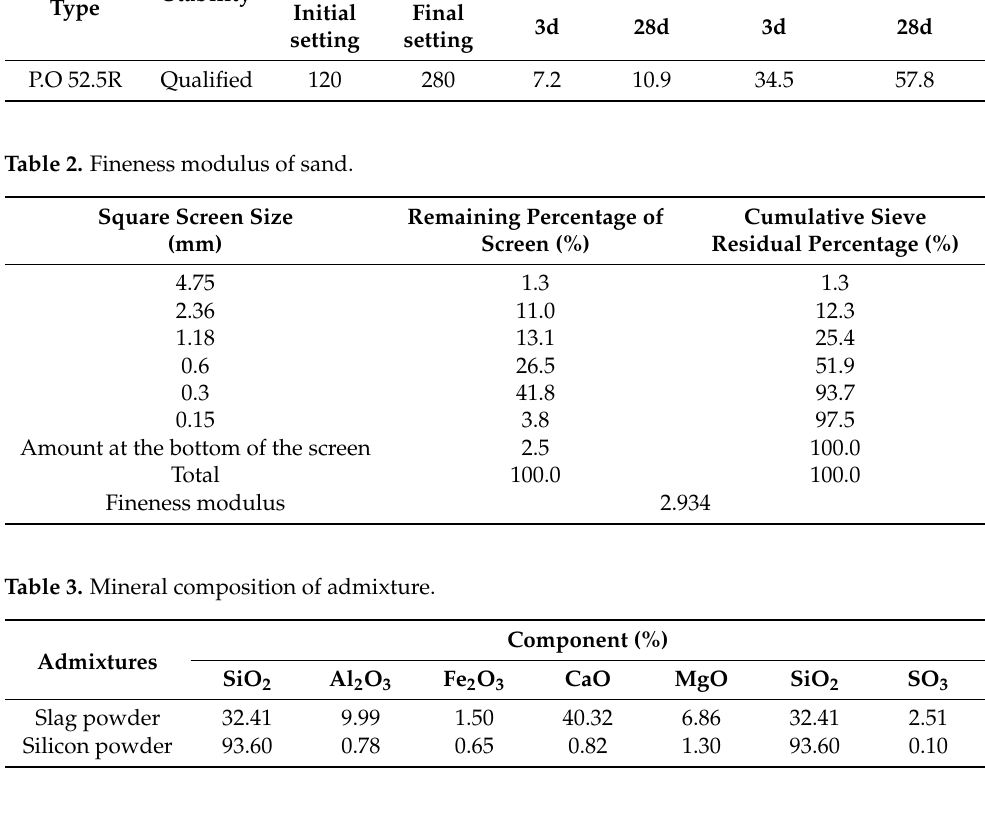
Table 4. Properties of water reducer.